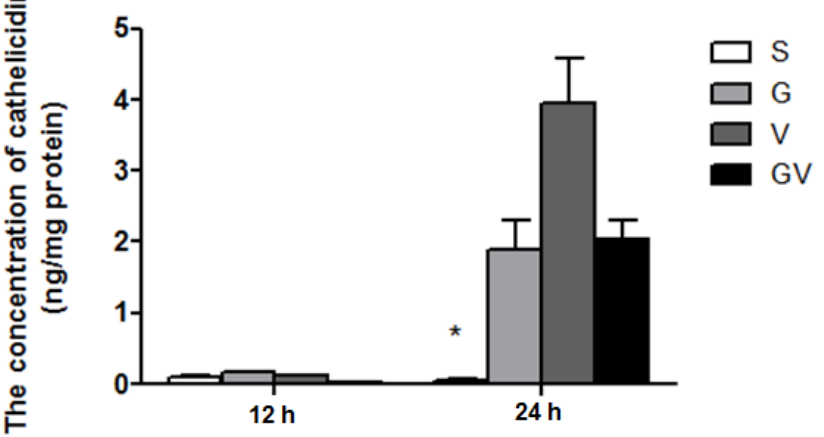
Figure 5. Cathelicidin concentrations in ileum tissues after cecal ligation and puncture at two time points. Data are presented as the mean ± standard error of the mean (SEM). n = 8 for each group. The groups are described in the legend of Figure 1. Differences among groups at the same time point were analyzed by a one-way analysis of variance using Tukey’s post hoc test. * Significantly differs from the other groups at the same time point ( p < 0.05).